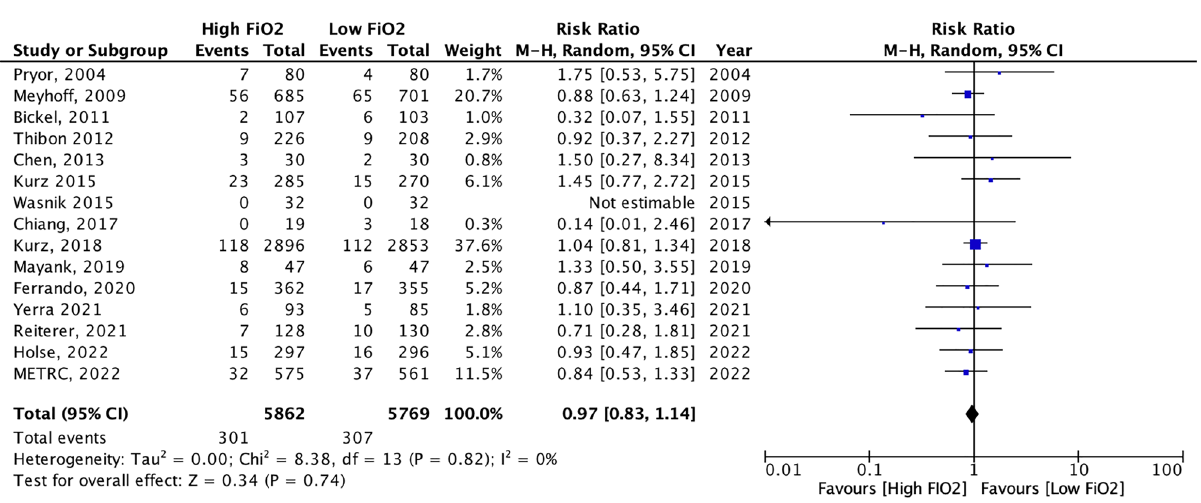
Figure 6. Sensitivity analysis of high versus low intraoperative FiO 2 on the incidence of deep SSI in patients included in the 15 studies for which data regarding superficial and deep SSI were available or retrieved from the